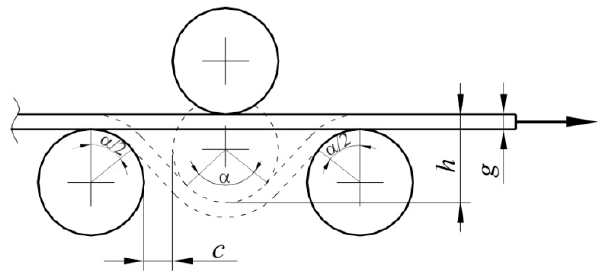
Figure 4. Parameters of a drawbead: c —clearance, h —drawbead height, g —sheet thickness, α —quarter contact angle of actual engagement of the strip over the middle roller.